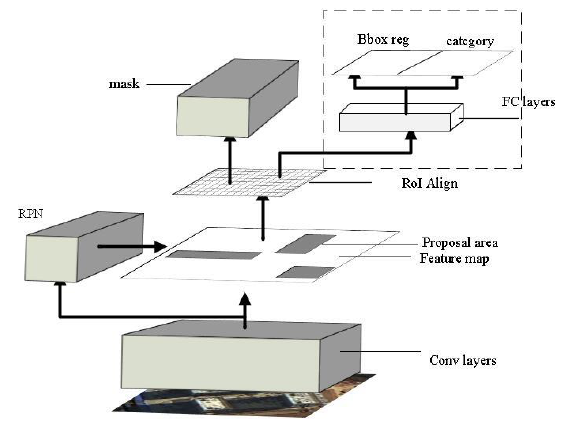
Figure 2. Architecture of the Mask R-CNN.